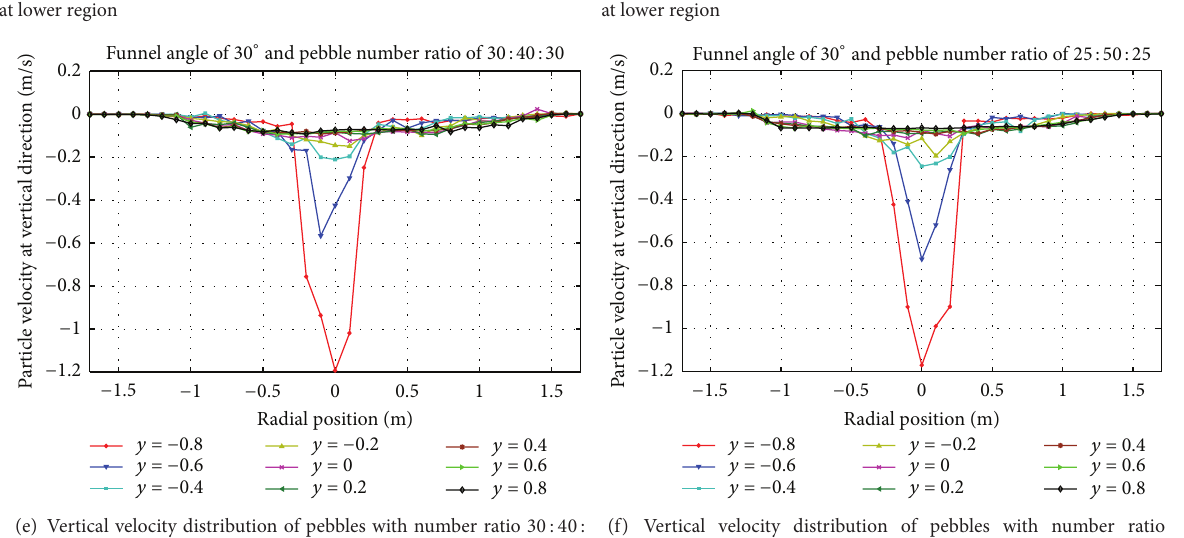
(c) Vertical velocity distribution of pebbles with number ratio 30:40:30 at lower region Funnel angle of 30 ∘ and pebble number ratio of 30 : 40 : 30